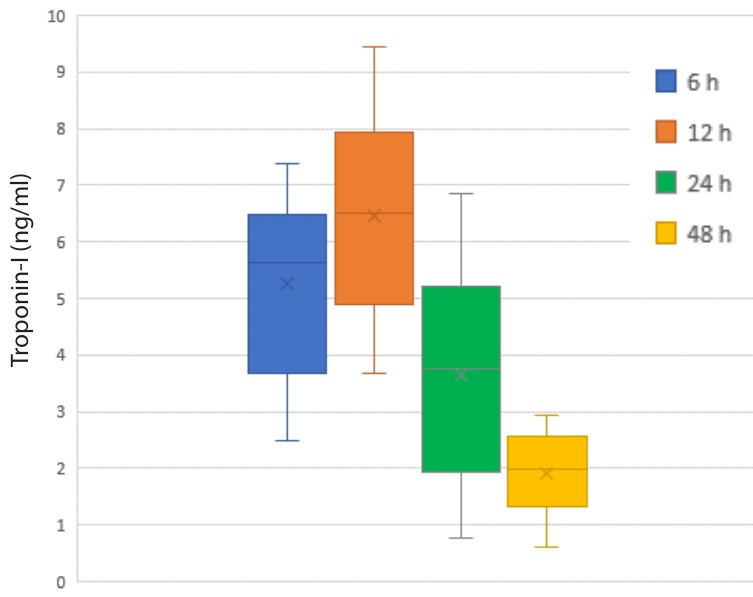
Fig. 2 – Cardiac enzyme values performed to evaluate postoperative myocardial damage in blood cardioplegia